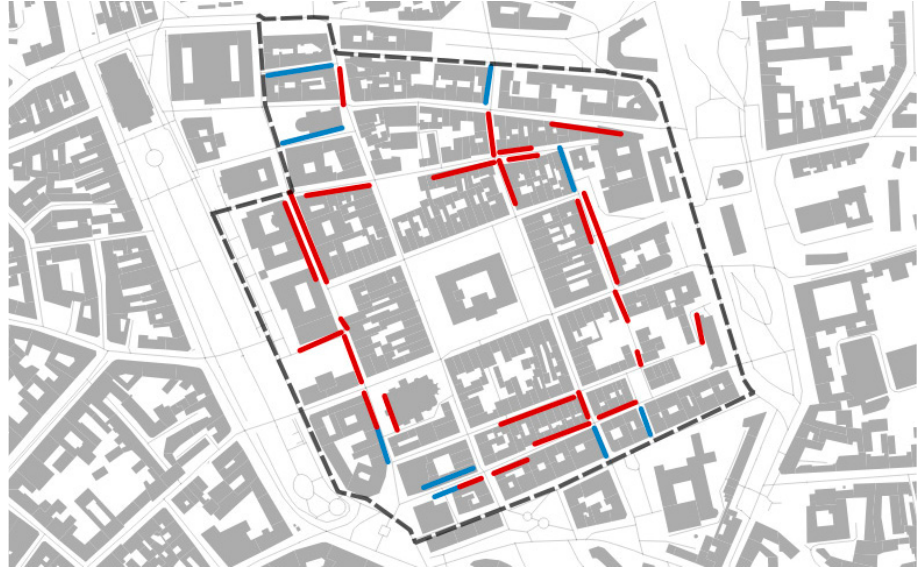
Figure 4. On-street parking in the pedestrian zone in 2016. Parking in permitted places is depicted in blue, and the prohibited places are in red. The scheme by R. Liubytskyi.